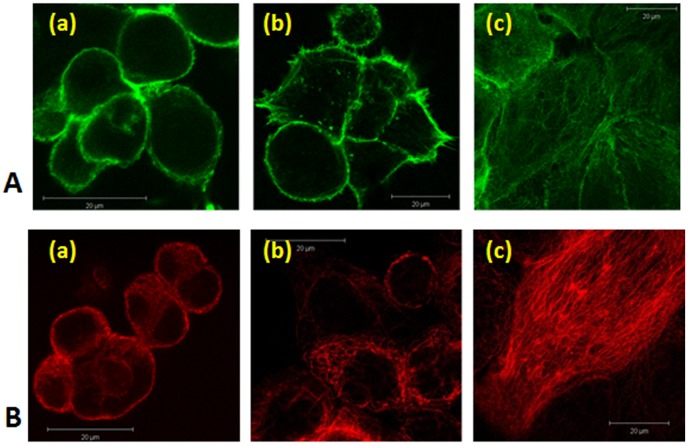
(A) Three different levels of stress fibers formation.(a) Low level, mostly cortical actin and almost no stress fibers, (b) Intermediate level, some fibers are formed, mostly in cell protrusions, and (c) High level, most of the cell’s central area is abundant with stress fibers. (B) Three different levels of microtubules formation: (a) Low level, mostly β-tubulin fragments and almost no cytoplasmic microtubules, (b) Intermediate level, some microtubules were formed inside the cell, and (c) High level, a dense network of microtubules was generated inside the cells.